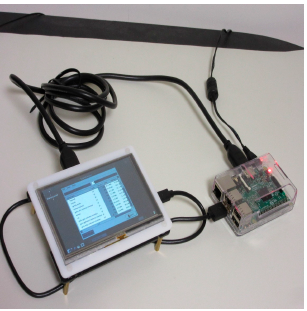
Figure 6. Raspberry Pi 3 experimental set-up.